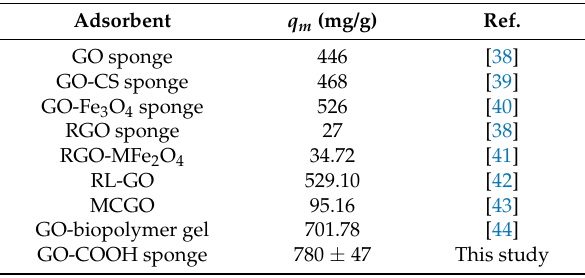
Table 2. Adsorption capacities of graphene sponges for